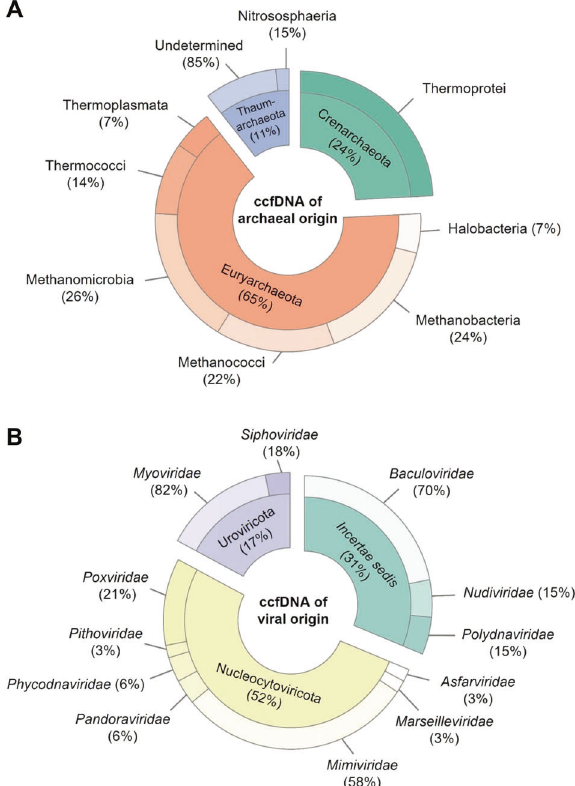
Fig. 6 ccfDNA fragments of archaeal and viral origins. Classi fi ca- tion of nonself reads using the Kraken taxonomic classi fi cation